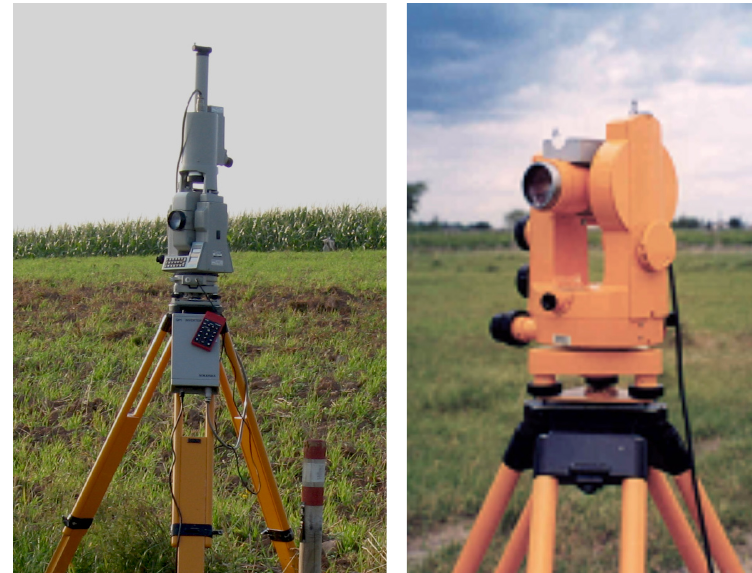
Figure 1 (left). A magnetic repeat station, showing a sensor of a proton precession magnetometer mounted on a tripod, and the limestone pillar sunk into the soil. Figure 2 (above, left). A gyro-theodolite to determine the true north direction. Figure 3 (above, right). A DI-fluxgate magnetometer serves to measure the magnetic declination and